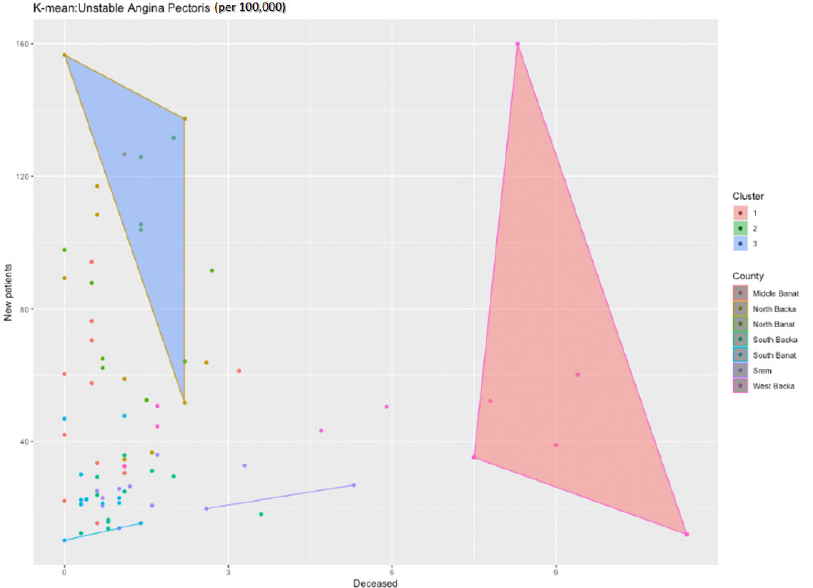
Figure 11. Identification of clusters during the analysis of newly diagnosed patients with unstable angina pectoris in the researched area.